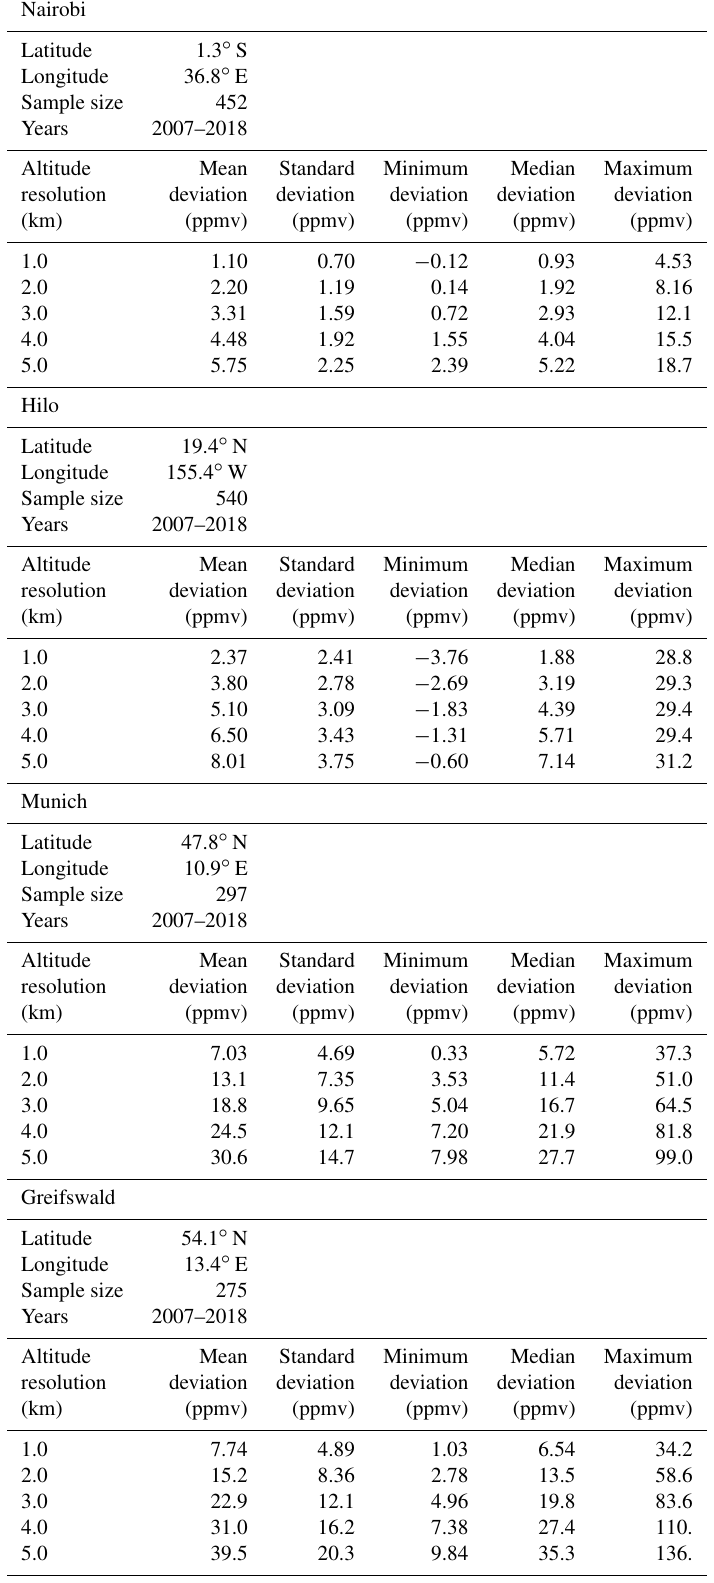
Table 4. Statistics for cold point water vapor saturation mixing ratio